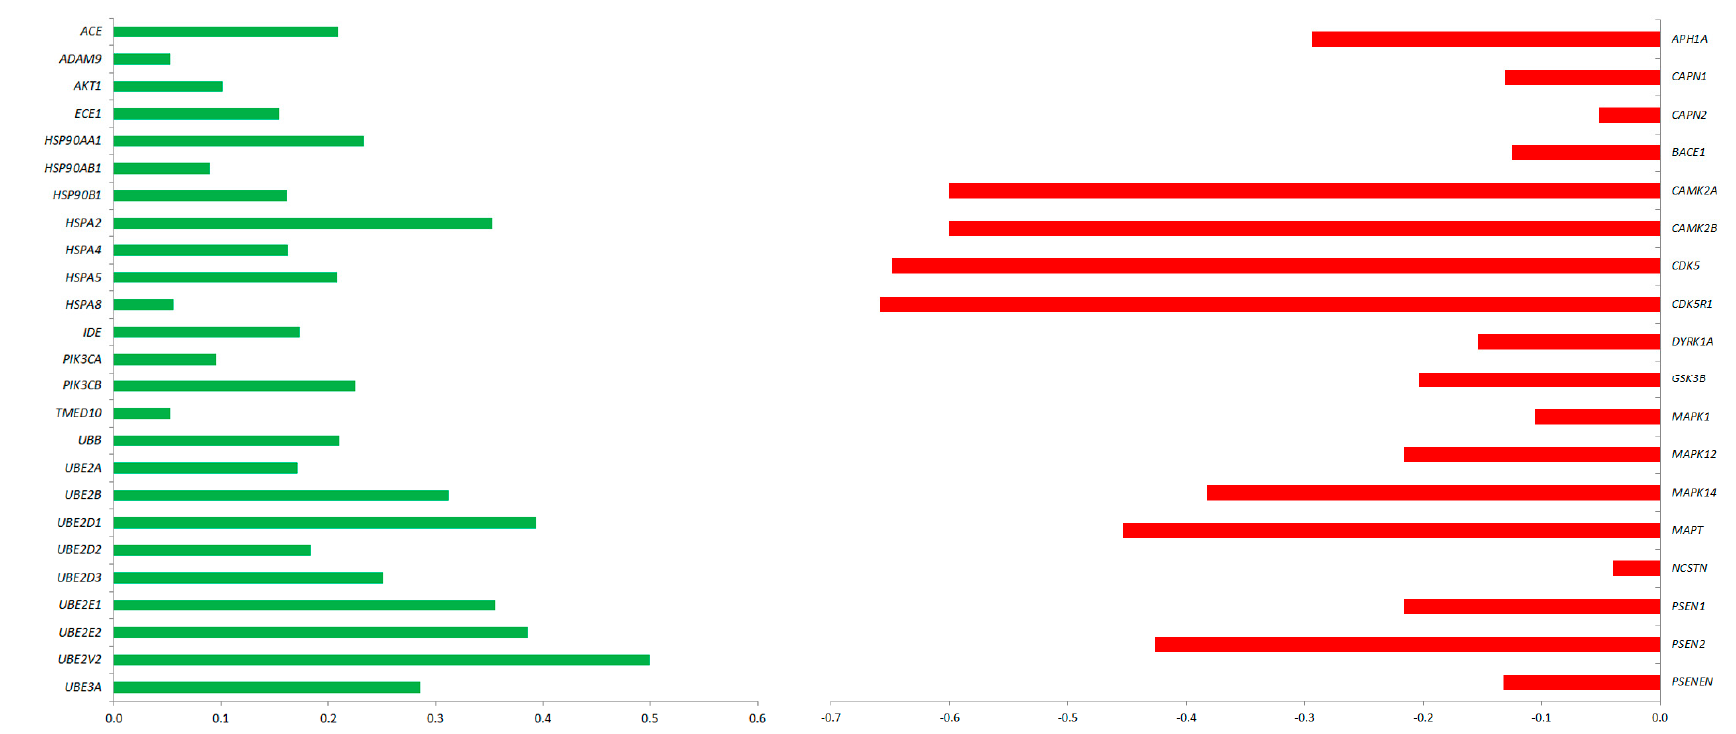
Figure 2. AD-related genes differentially expressed between CBD-GMSCs and CTR-GMSCs. The fold change is expressed in log10 ( q ≤ 0.05, Benjamini–Hochberg False Discovery Rate). Upregulated genes are shown in green, while downregulated ones are in red.